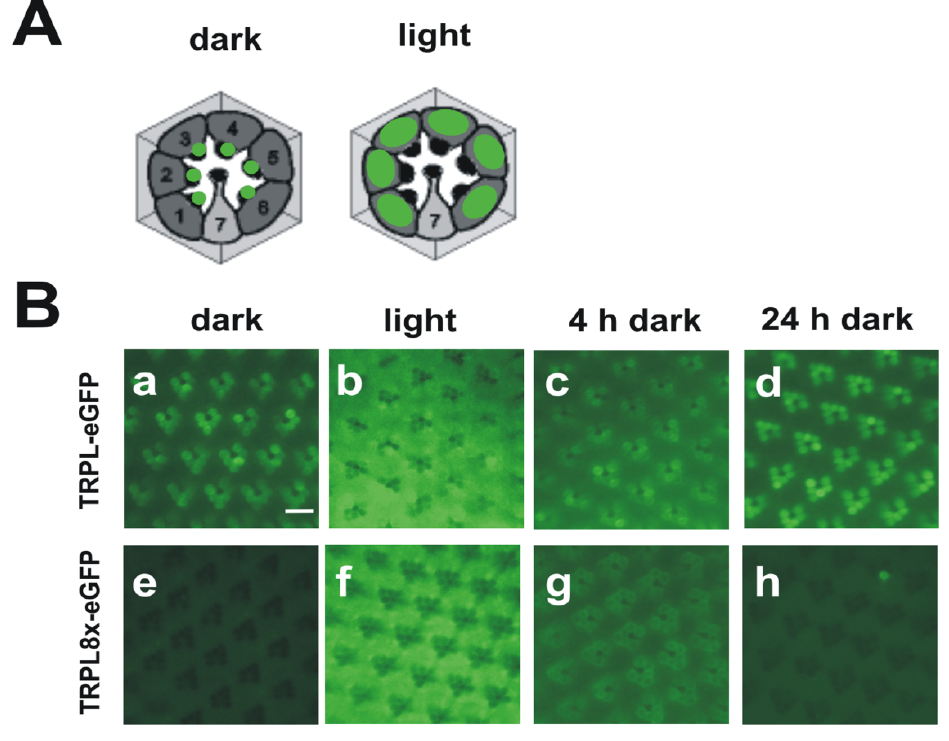
Figure 3. Light-dependent localization of Drosophila wild type TRPL and a TRPL channel lacking C-terminal phosphorylation sites (TRPL8x-eGFP). ( A ) Cartoons of cross sections through ommatidia showing localization of wild type TRPL in green. In dark-adapted flies, photoreceptor cell bodies; ( B ) Water immersion images of intact eyes of flies expressing TRPL-eGFP or TRPL8x-eGFP. In TRPL8x-eGFP the eight C-terminal